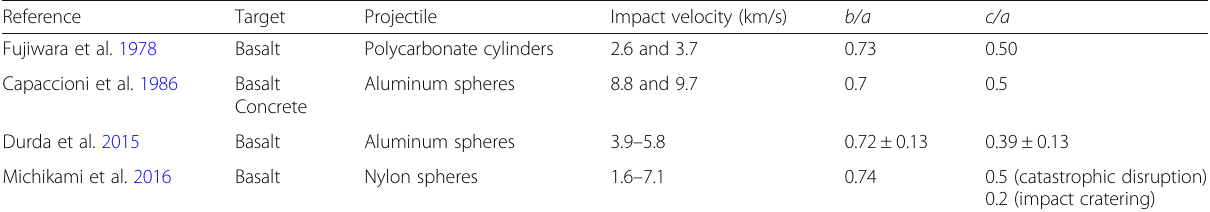
Table 6 Compilation of fragment ratios b / a and c / a from several publications in the literature. Dimensions are defined to be a ≥ b ≥ c